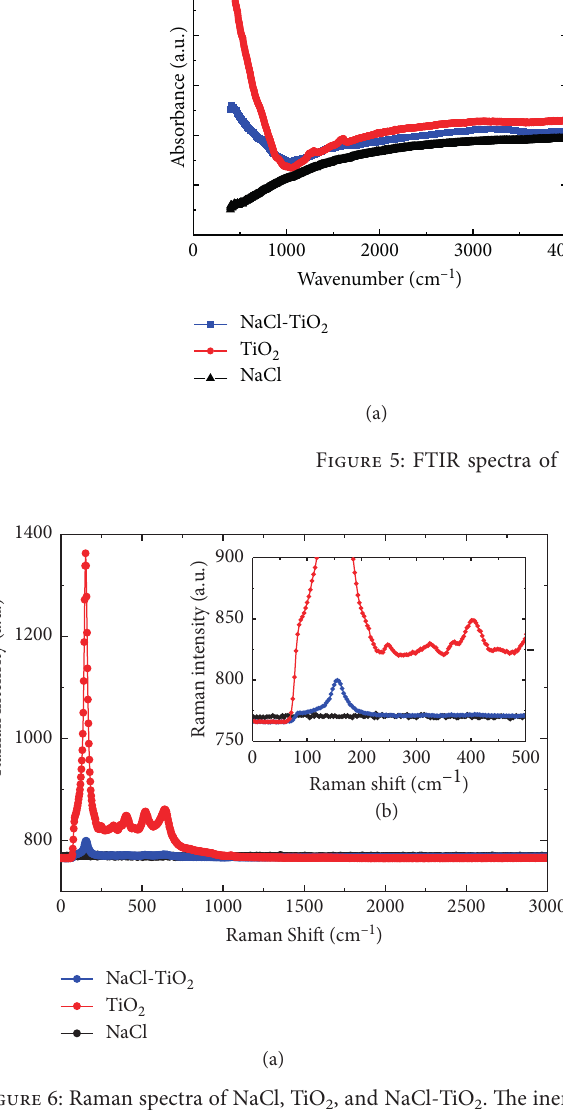
Figure 6: Raman spectra of NaCl, TiO 2 , and NaCl-TiO 2 . The inert (0 to 500cm − 1 ) highlights the peak at 152cm − 1 approximately, which is the characteristic of TiO 2